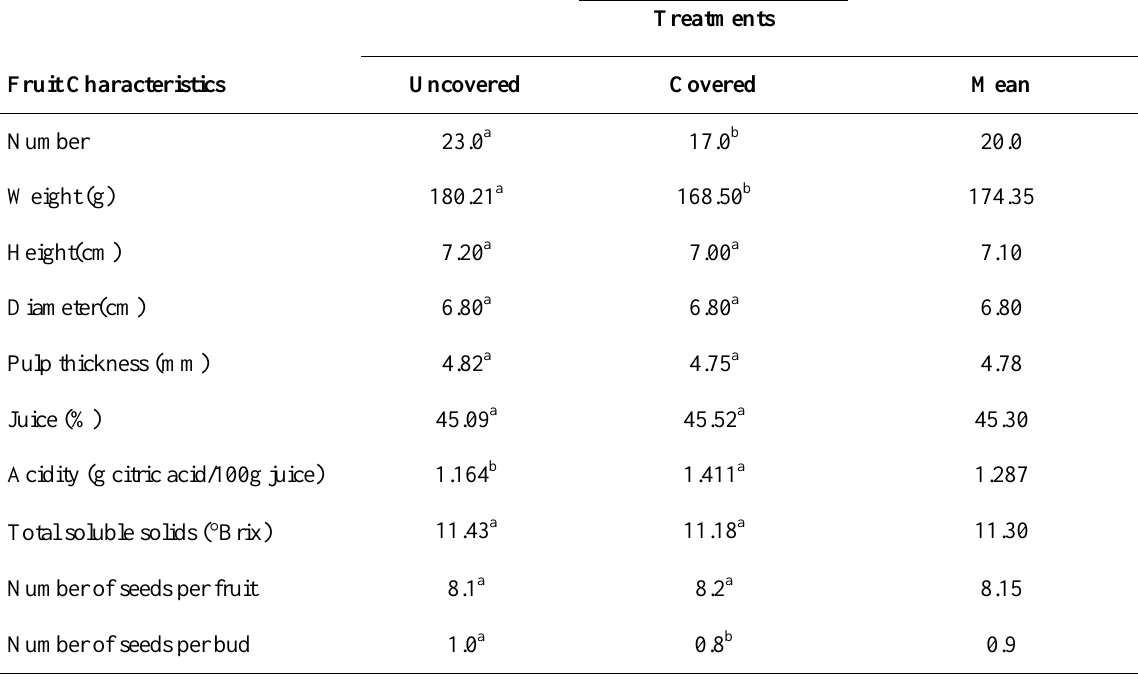
Table 1. Average characteristics observed in sweet orange ( Citrus sinensis L. Osbeck, var. Pera- Rio) in fruits from uncovered and covered flowers in 1996. Treatments Fruit Characteristics Uncovered Covered